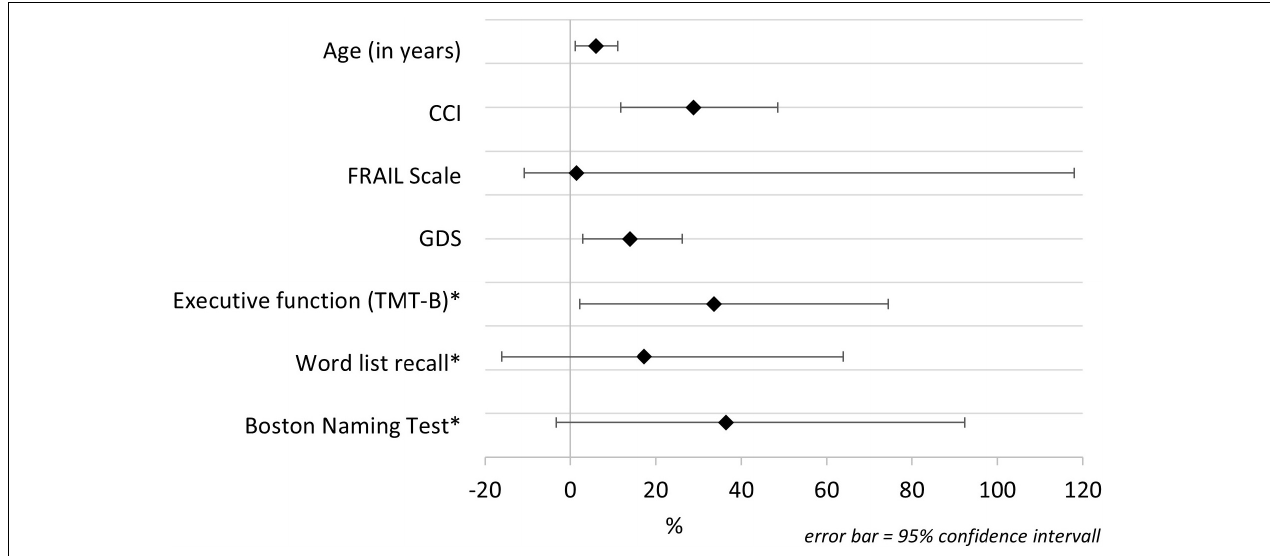
FIGURE 1 | Change in the risk of reported delirium symptoms over an 8-year period. CCI, Charlson Comorbidity Index; GDS, Geriatric Depression Scale; TMT-B, Trail Making Test B. *Cognitive parameters are presented inverted.